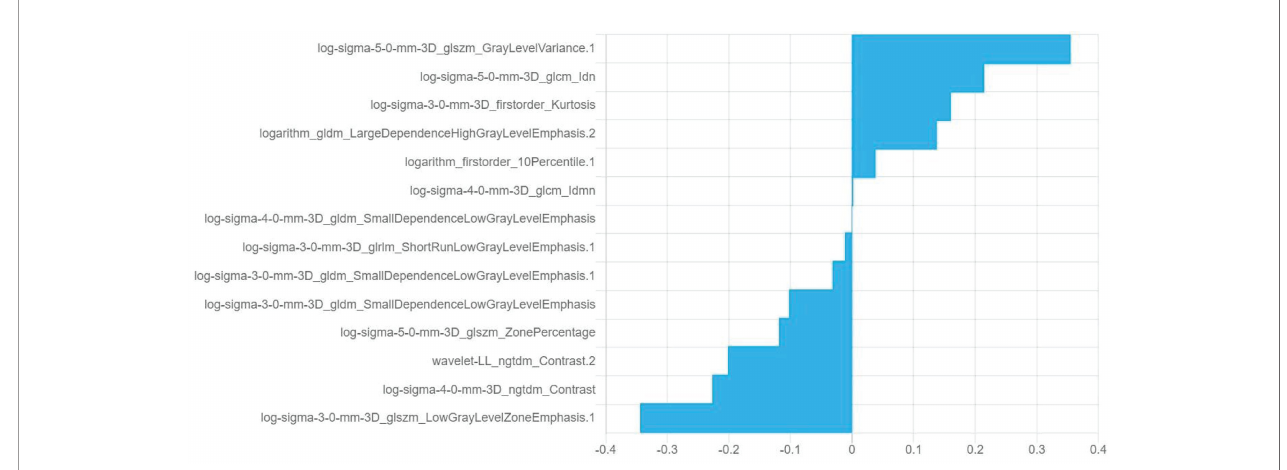
TABLE 4 | Cox univariate and multivariate proportional hazard models of risk factors for recurrence of bladder cancer. Factors Univariate Multivariate